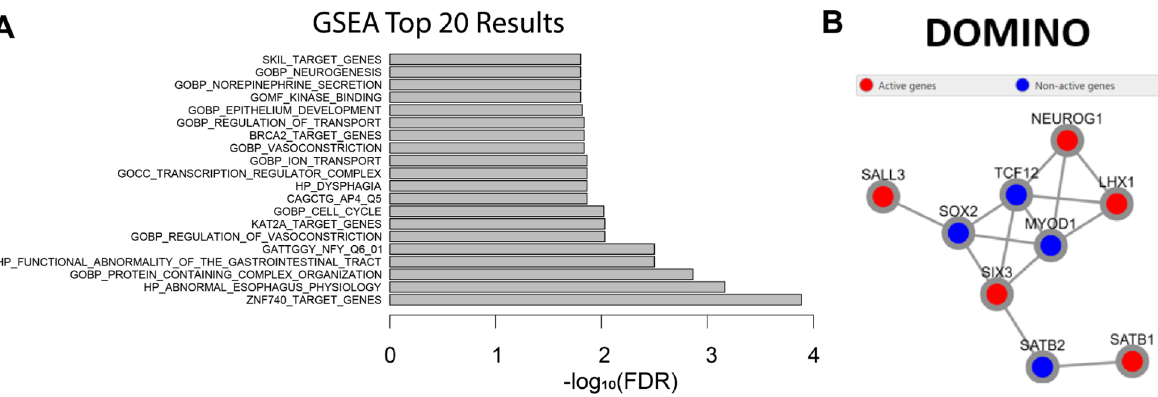
Figure 5. Gene and protein interaction of genes affected by variants. ( A ) GSEA was used to find enriched processes among the genes affected by the HcDNVs. Y-axis indicates the top 20 enriched categories and the x-axis indicates the − log 10 of the FDR scores. ( B ) DOMINO was used to find subnetworks of protein–protein interactions and the cellular processes that are enriched for those genes. One significant network is shown above where the red active nodes are genes affected by the HcDNVs and the blue inactive nodes are intermediate proteins added by DOMINO. The top five enriched processes are: DNA-binding transcription factor activity RNA polymerase II specific, RNA polymerase II transcription regulatory region sequence specific DNA binding, DNA-binding transcription factor activity, and transcription regulatory region nucleic acid binding.